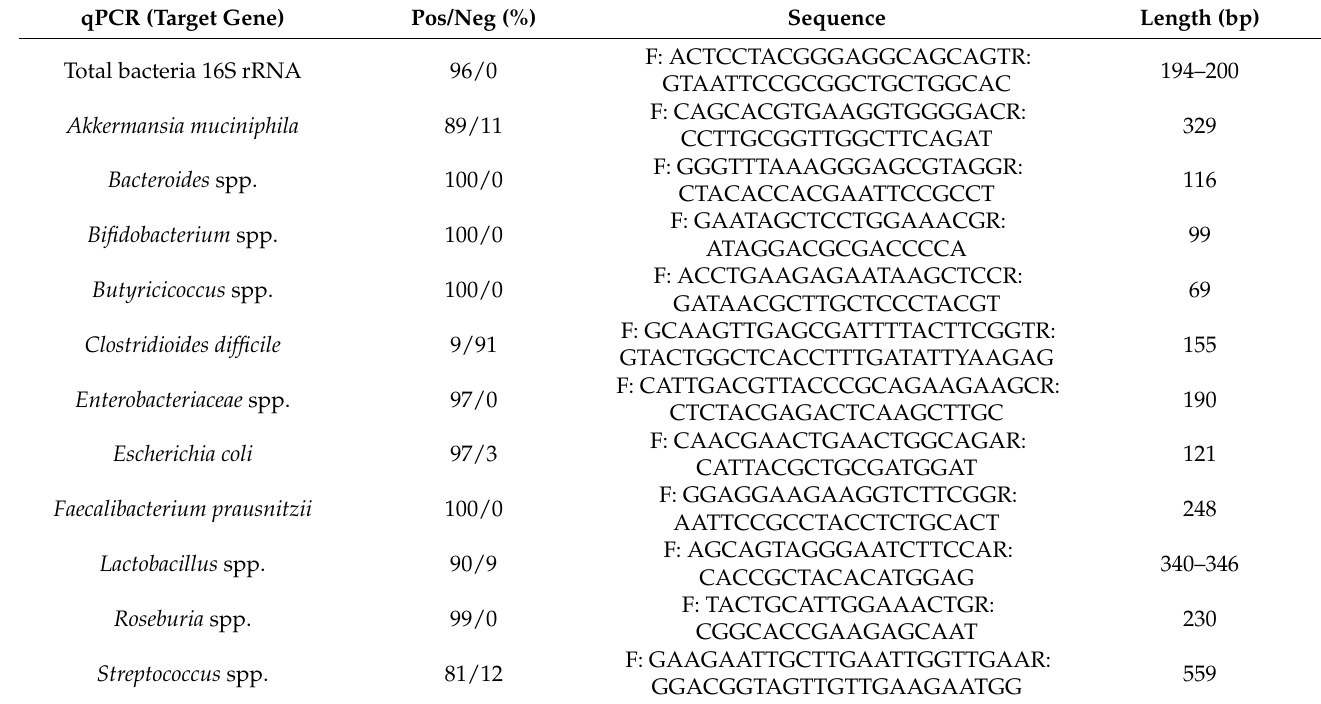
Table 3. Real-time qPCR primers sequences targeting different microbiota in the cecal content on post-hatch day 35